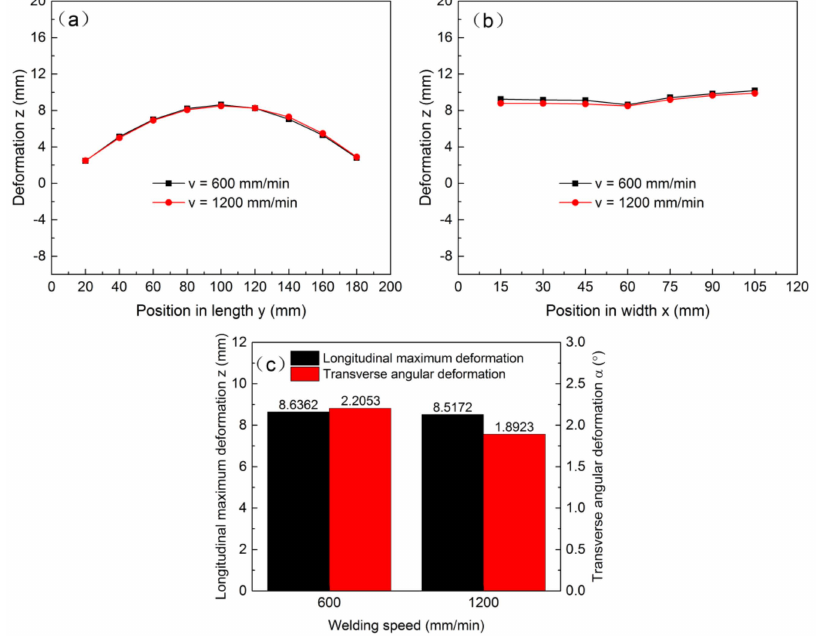
Figure 10. Deformation comparison for di ff erent welding speeds: ( a ) in longitudinal direction at position x = 0, ( b ) in transverse direction at position y = 100 mm, and ( c ) longitudinal maximum bending deformation and transverse angular